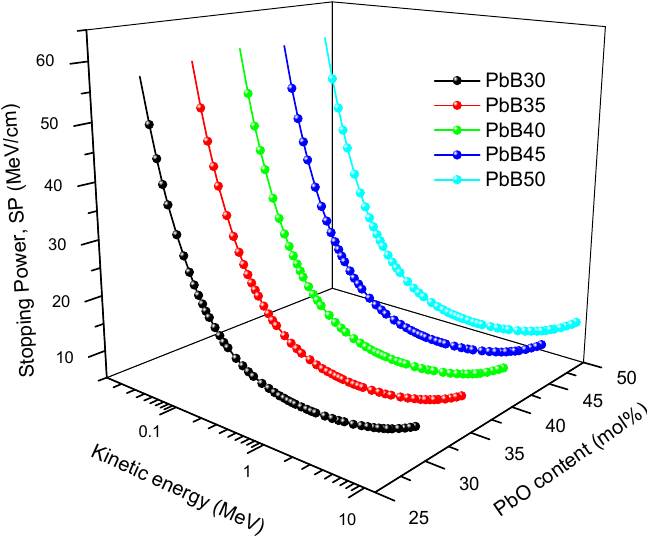
Figure 11. Total SP of electron as function of kinetic energy and PbO content of the PbB-glasses.